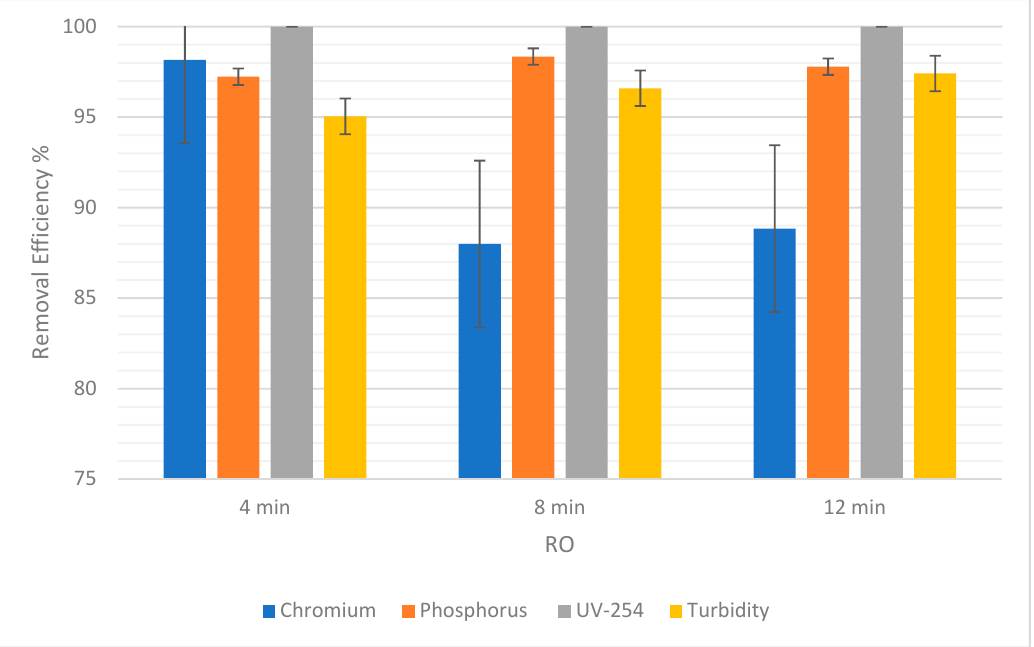
Figure 9. The efficiency of removal of pollutants for RO at 4, 8, and 12 min with error bars.